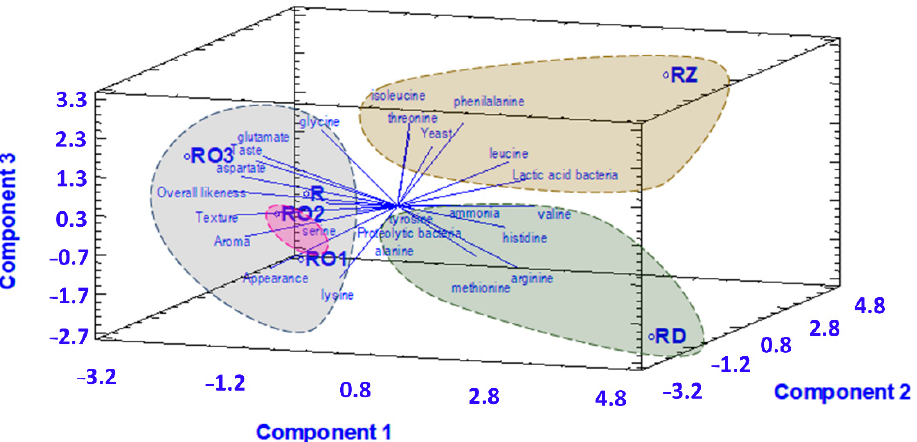
Figure 6. Principal component analysis 3D biplot of correlation of fungal species with chemical and sensory characteristics of fermented soybean samples.